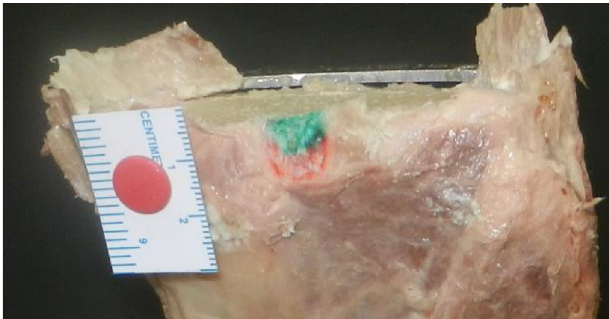
Figure 2. Footprint of PCL on tibia after bone resection. Antero-lateral bundle is marked with green and postero-medial bundle with